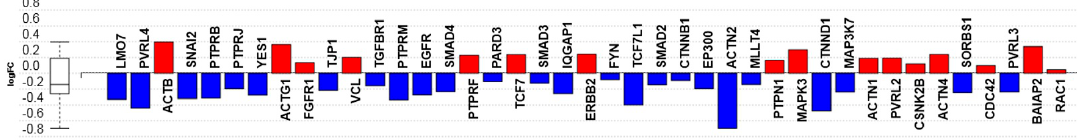
Figure 5. The adherens junction pathway mRNA transcripts regulated in response to C16 ceramide-enriched LDL in human podocytes. Podocytes were induced with C 16 ceramide-enriched or native LDL and RNA-seq assay was performed as described in Figure 3 legend. Figure generated by iPathwayGuide (Advaita Bioinformatics) software; log FC, logarithm of fold change of gene expression. Box and whisker plot: the ends of the box are the upper and lower quartiles, box spans the interquartile range. Horizontal line inside the box denotes the median and the whiskers are the two lines outside the box extend to the highest and lowest observations.